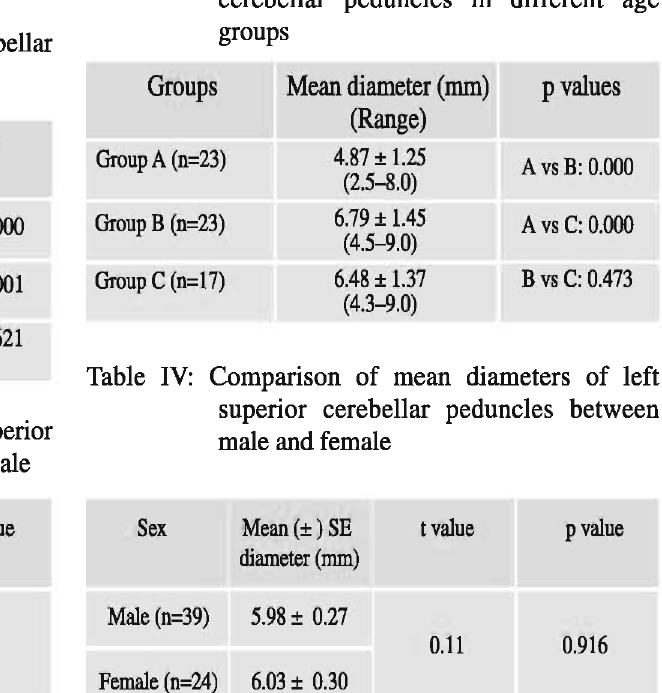
Table III: Mean diameters of the left superior